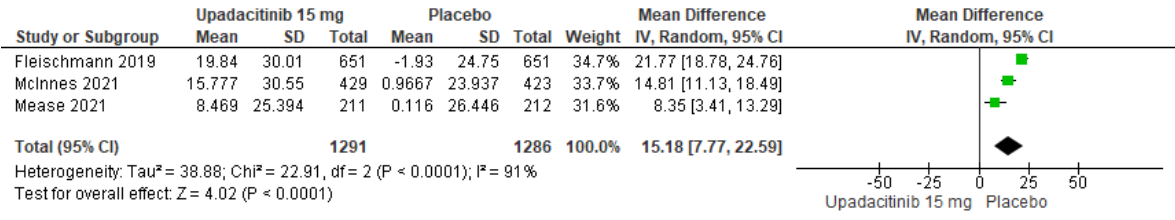
Figure 3. Forest plot of the comparison: upadacitinib vs. placebo. Outcome: low-density lipoprotein cholesterol (mg/dL) [17,20,22].